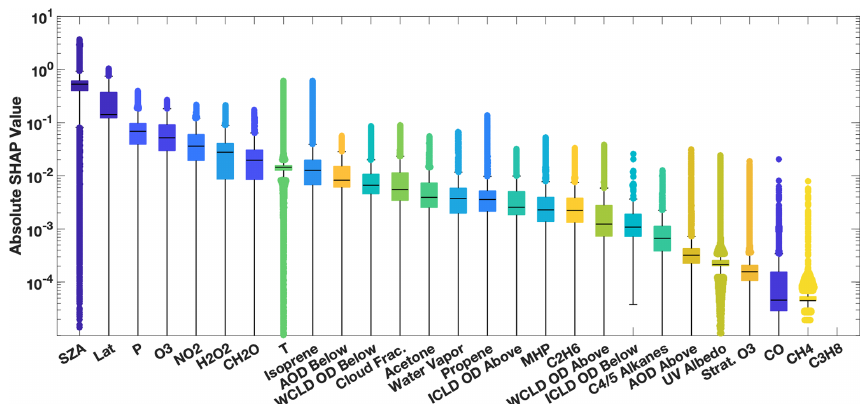
Figure 6. Distribution of the absolute SHAP value for each parameterization input for July from an untuned version of the parameterization of OH. Input parameters are sorted by order of relative importance. The median is indicated with the black line, the edges of the box represent the interquartile range, and the whiskers represent the 5th and 95th percentile. Values outside this range are indicated with circles. Note that the SHAP value for propane is zero, indicating that it is not used by the untuned